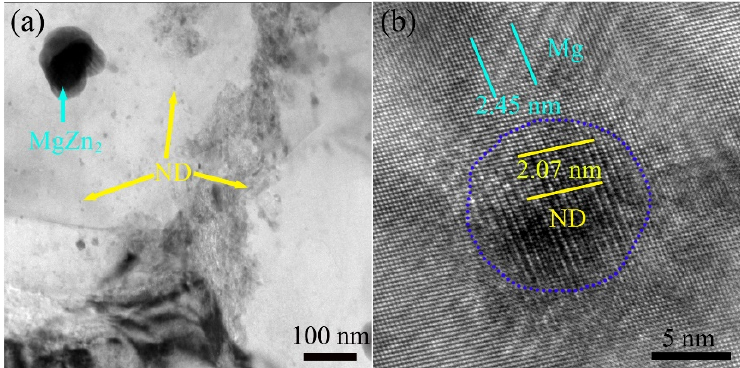
Figure 2. The TEM of as-extruded 0.05 wt.% ND/ZK60 composite: ( a ) microstructure and ( b ) interface bonding.